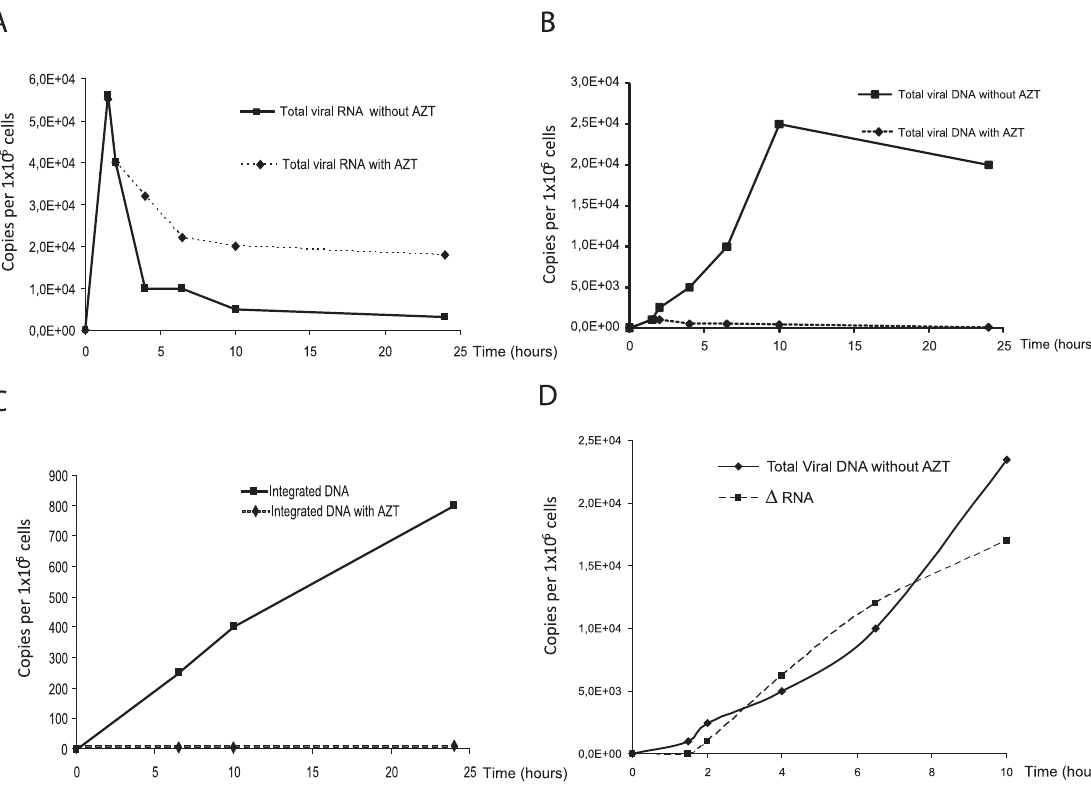
Figure 2. Kinetic analysis of PFV RNA and DNA synthesis. A representative experiment is shown. U373-MG cells were infected in the presence or absence of AZT (100 m M). The drug was added 2 hours before infection and kept on cells during the experiment. Levels of intracellular PFV DNA and RNA were monitored during the first hours of infection. ( A ) Dynamics of viral RNA with and without AZT monitored by real-time RT-PCR. Synthesis and fate of total viral DNA ( B ), integrated DNA ( C ) monitored by real-time PCR. Viral RNA involved in the reverse transcription step as well as viral DNA synthesis were monitored ( D ). At each time point post-infection, quantification of viral RNA copies without AZT is subtracted from viral RNA copies with AZT.